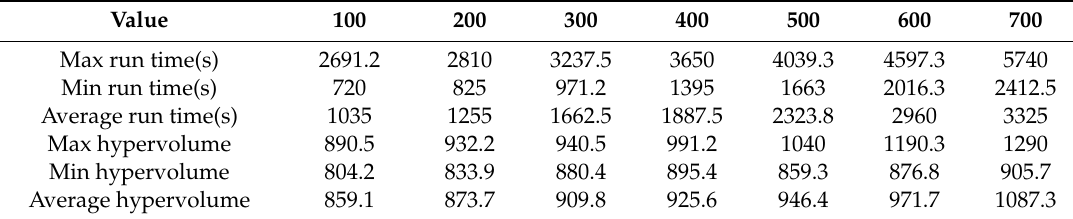
Table 5. Run time and hypervolume under di ff erent iteration numbers.